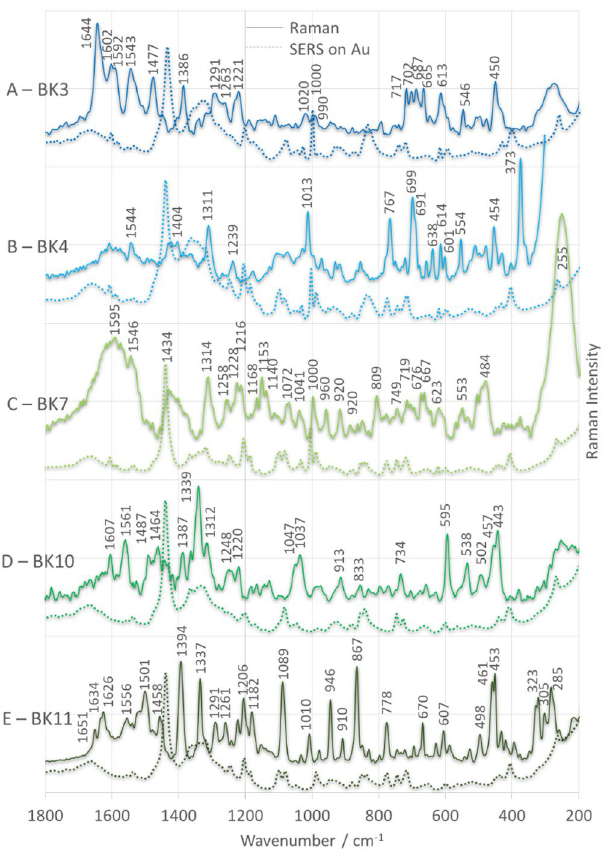
Figure 6. Raman (dashed line traces) and SERS (solid line traces) spectra of BK analogs adsorbed on